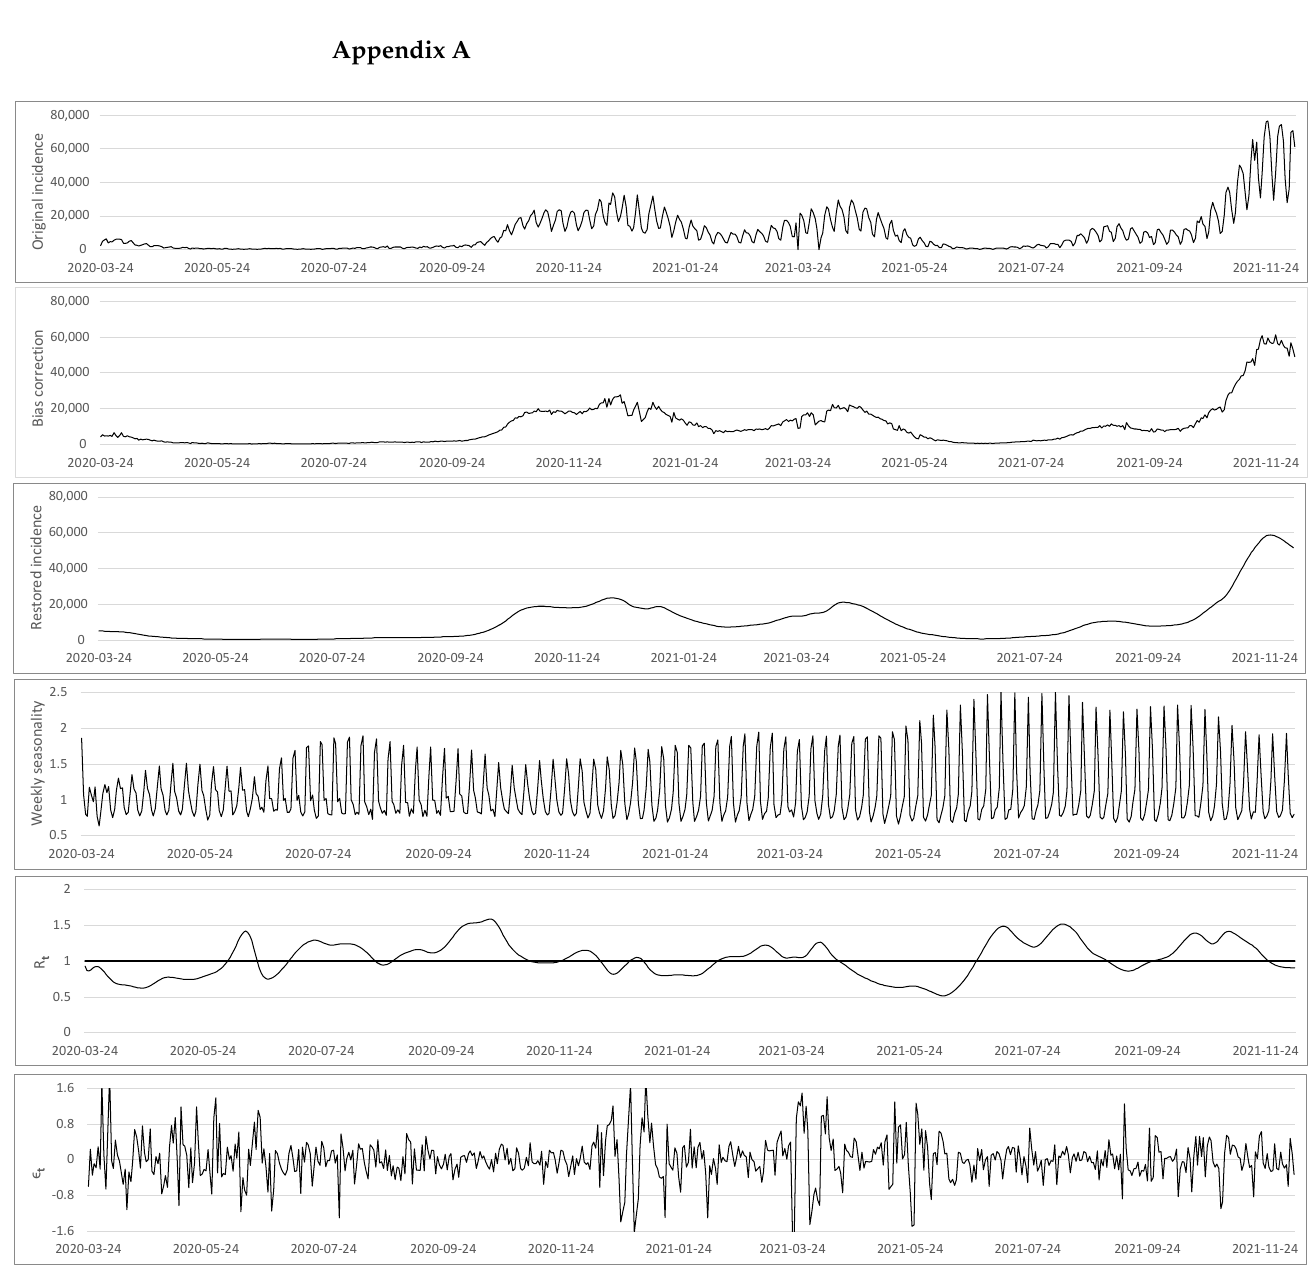
Figure A1. From top to bottom: (i) the original incidence curve of Germany i 0 after bias correction ˆ i t , (iii) the restored incidence curve using the renewal equation i r bias correction factors q t , (v) the reproduction number estimation R t and (vi) the normalized error − ˆ i t ) / ( i r ) a , where a is the optimal exponent obtained by regression (see Table ε t = ( i r t t